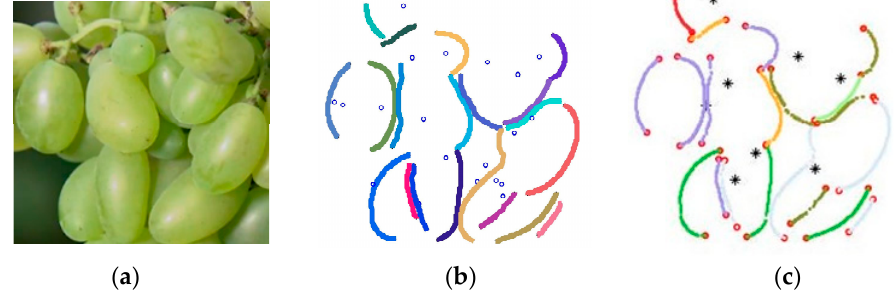
Figure 12. The model test results of ARRA grape berries. ( a ) is original image, ( b ) is contour segment calculation, ( c ) is contour segment combination. The red dot represents the concave point of the contour line segment of the grape berry; the blue dot represents the position of the centroid point of the contour segment; “ ✴ ” represents the position of the center point calculated for each group of contour line segments; different contour line segments are marked with different colors.